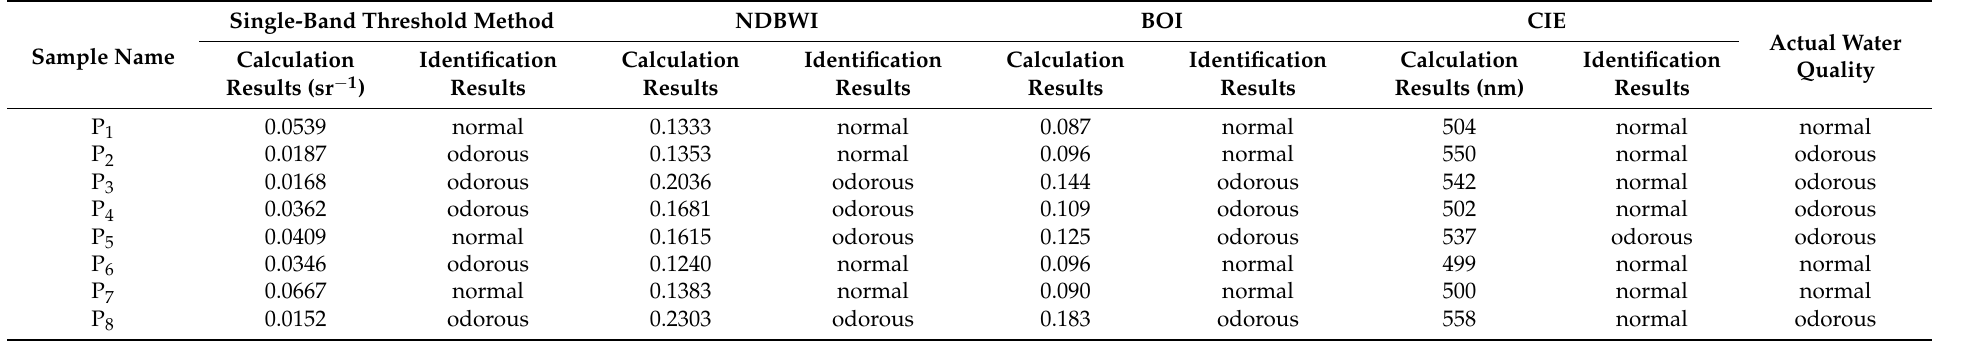
Table 4. Accuracy